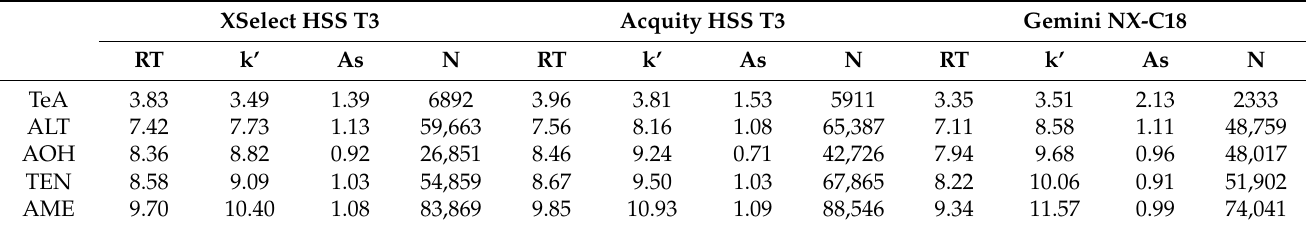
Table 3. Chromatographic parameters obtained on the separation of Alternaria toxins using the three most suitable columns (attached with a